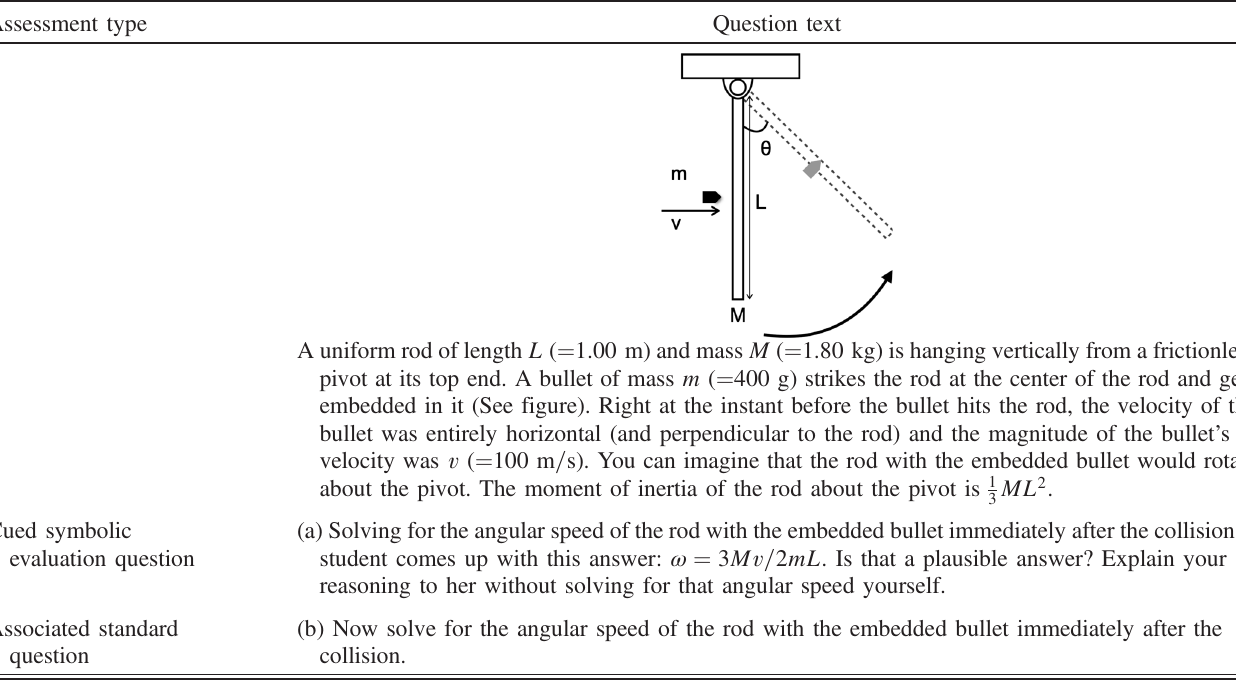
TABLE IV. The cued symbolic evaluation question and associated standard